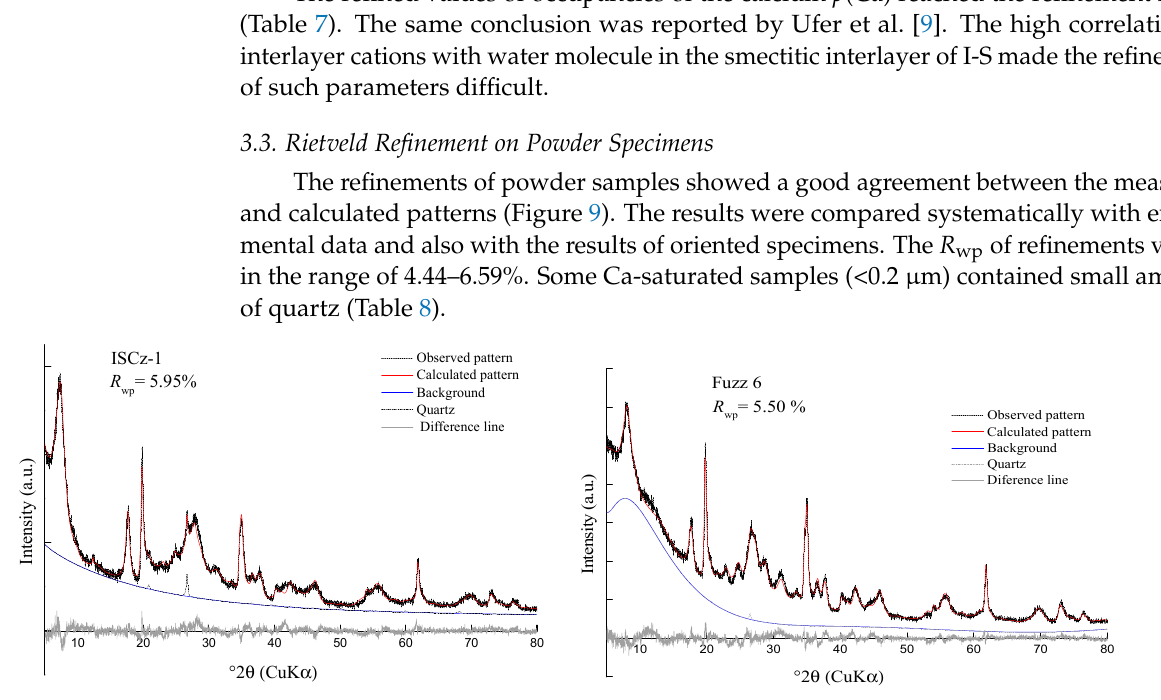
The refined values of occupancies of the calcium p (Ca) reached the refinement limits